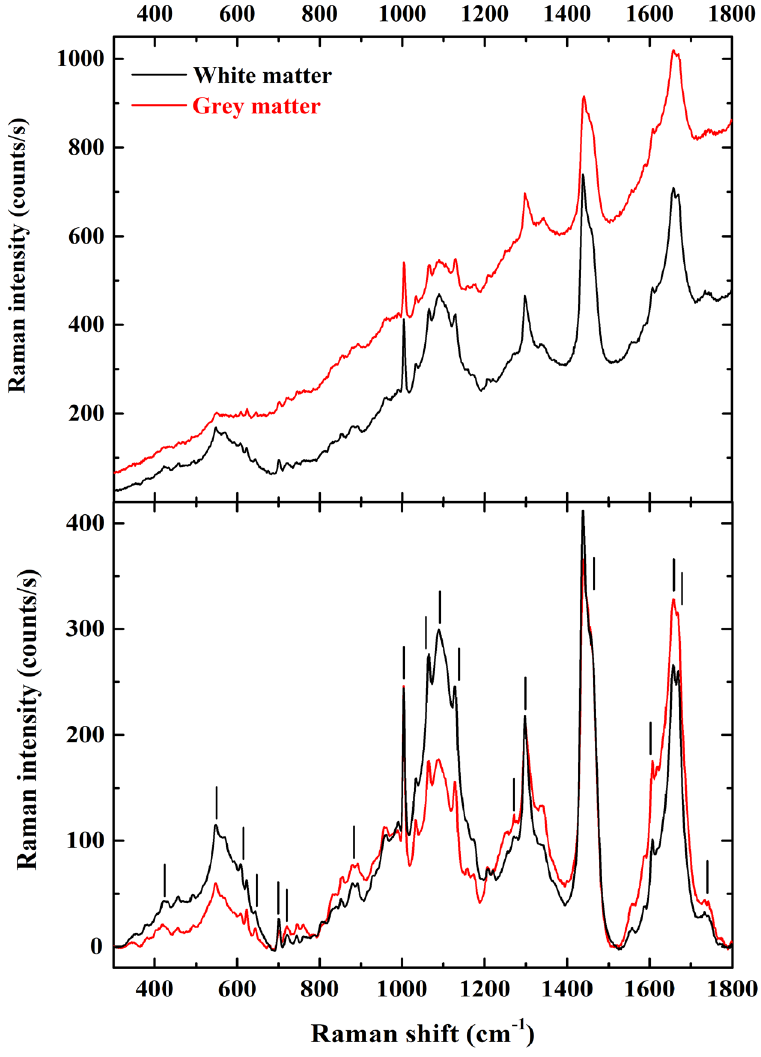
Figure 2. ( above ) Representative Raman spectra from the white matter region (black trace) and from the grey matter (red trace) of healthy mouse spinal cord section. The exposure time was 10 seconds for 12 accumulations with 6 mW/ μ m 2 laser power. ( below ) Baseline corrected trace obtained averaging 21 white matter spectra (in black) and 21 grey matter spectra (in red) of healthy mouse spinal cord section. The marked bands are identified in the supplementary